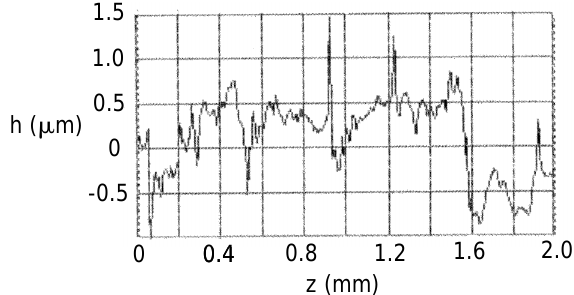
FIG. 4. Surface profile along the tube axis measured by a